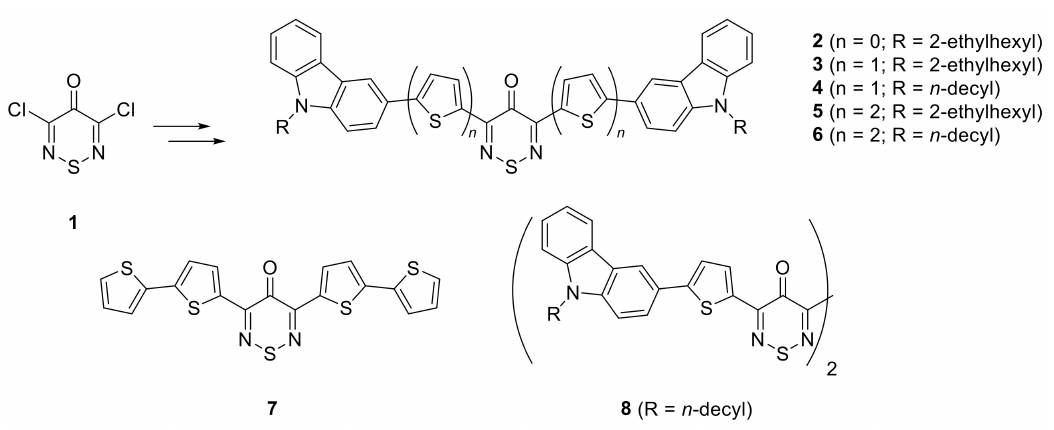
Figure 1. Known 1,2,6-thiadiazine containing polycyclic small